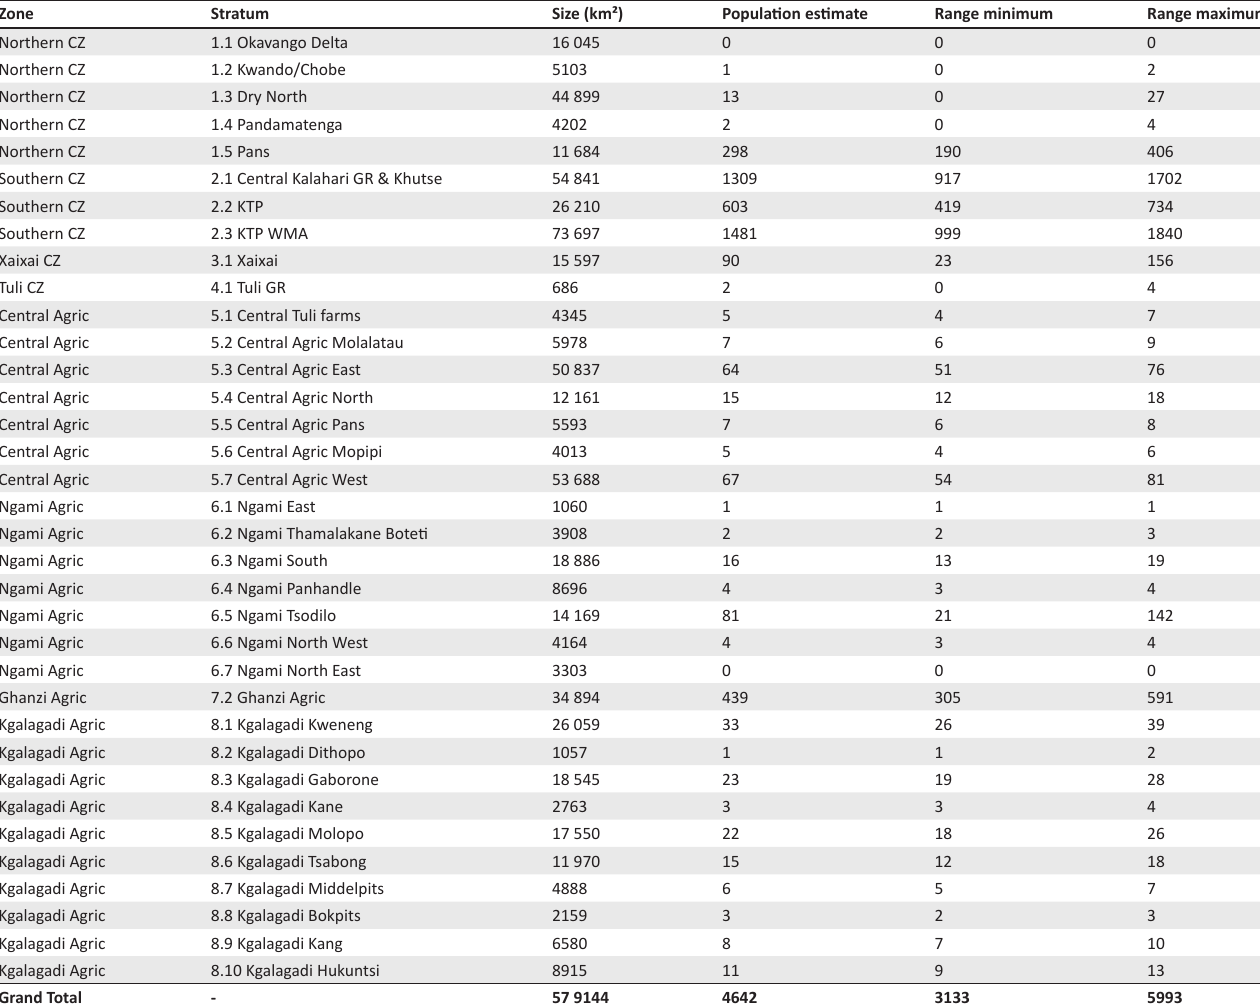
TABLE 4: Population estimates per stratum of brown hyaenas ( Parahyaena brunnea ) in Botswana based on surveys conducted between 2005 and 2015. Zone Stratum Size (km²) Population estimate Range minimum